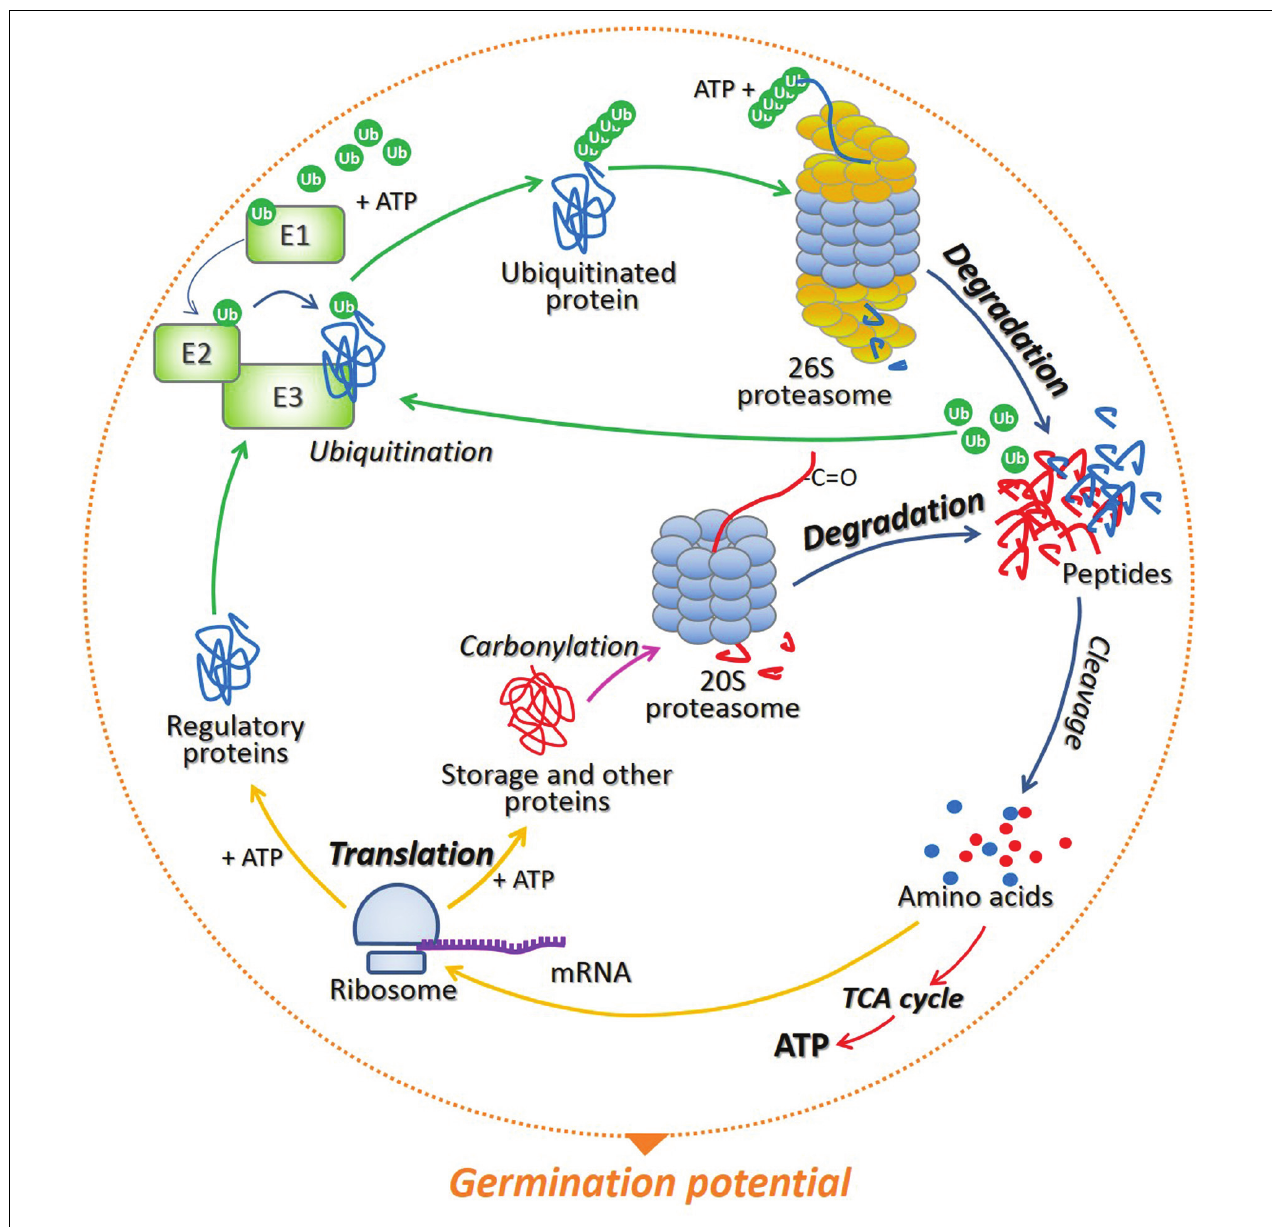
FIGURE 1 | The model of protein recycling in cells of germinating seeds. During translation preformed on ribosomes associated with particular mRNAs, a wide range of proteins are synthetized, and the energy in the form of ATP is required for this process. The specific regulatory proteins which have completed their mission in various cellular processes can be polyubiquitinated by the cascade of three enzymes E1, E2, and E3. The attachment of at least 4 ubiquitin (Ub) molecules target proteins for proteolysis via 26S proteasome in an ATP-dependent manner. As soon as the substrate is degraded, Ub are released and can be reused in the labeling and degradation of another target protein. On the contrary, storage and other (e.g., damaged) proteins, which are irreversibly oxidized (carbonylated) during seed germination, undergo ATP- and Ub-independent degradation by 20S proteasome. Short peptides resulting from proteasomal proteolysis are then cleaved